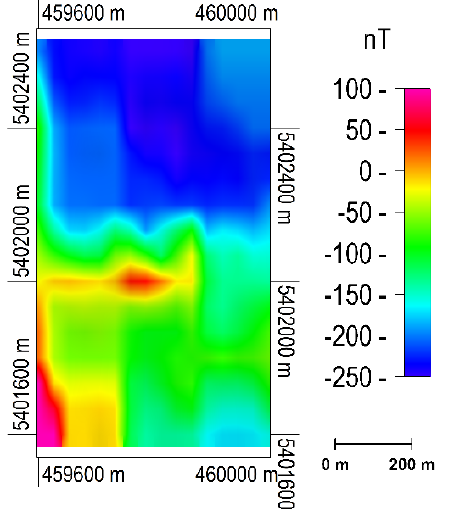
Figure 2. The Reid-Mahaffy test site. The figure shows a map of 1068 Hz coaxial DIGHEM data.